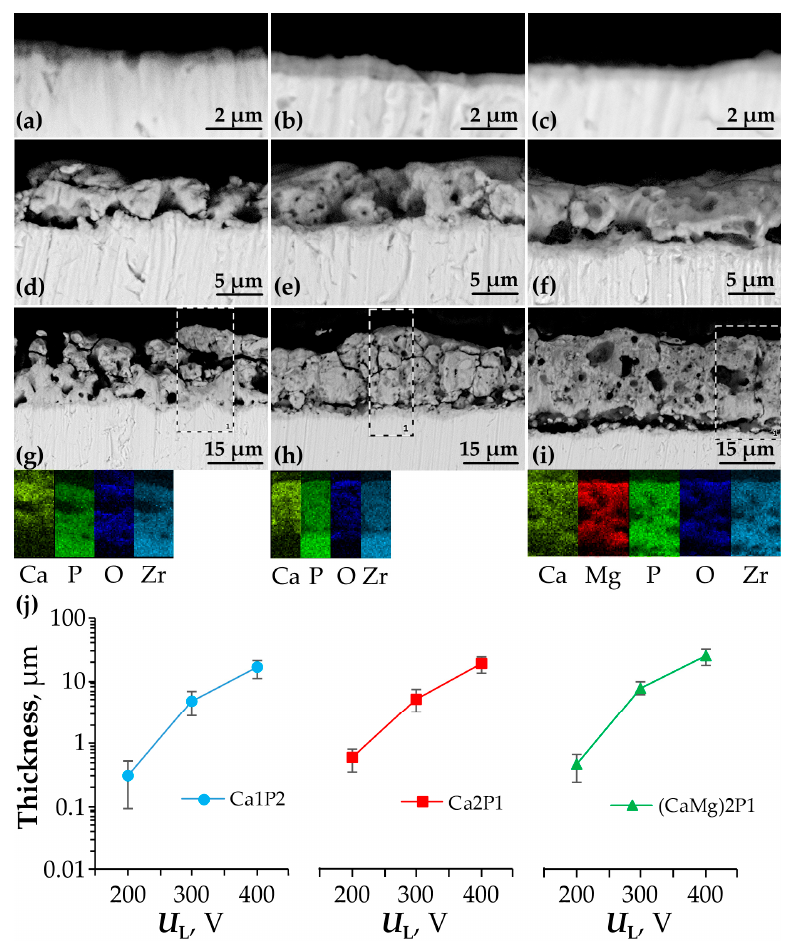
Figure 6. SEM cross-sections of the PEO coatings formed on zirconium up to 200 ( a – c ), 300 ( d – f ), and 400 V ( g – i ) in the Ca1P2 ( a , d , i ), Ca2P1 ( b , e , h ), and (CaMg)2P1 ( c , f , i ) solutions. Rectangles in the images of the coatings produced at 400 V represent the regions of EDX elemental mapping, results of which are presented directly below the corresponding images. The ranges of the measured thickness ( j ) were calculated as mean ± SD for each coating.